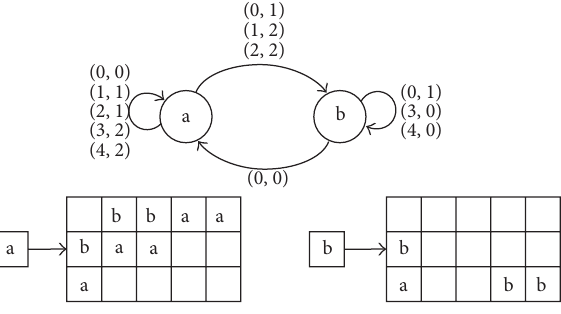
Figure 1: The substitution rules associated with 𝐾 𝑇